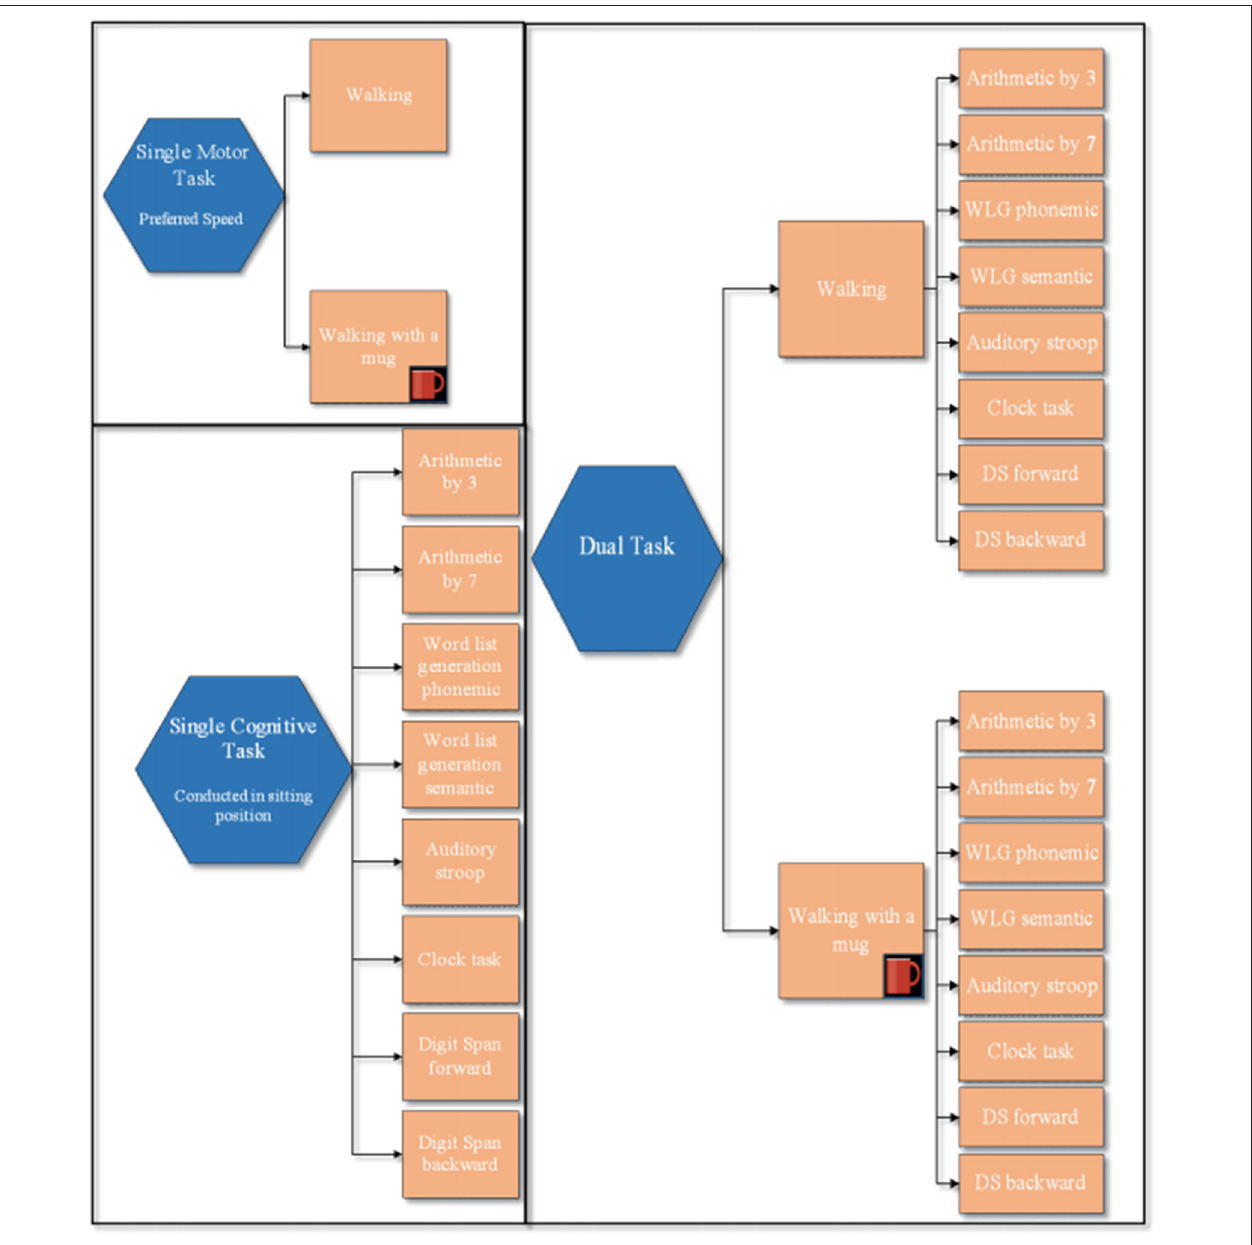
FIGURE 1 | Experimental protocol. This figure illustrates: block of 2 single motor tasks, block of the 8 single cognitive tasks, and the two blocks of dual task paradigms: walking with and without a mug, while simultaneously performing the 8 cognitive tasks. The order of each ST within a block was randomized. The order in which tasks within each block were performed as the order between blocks was randomized.